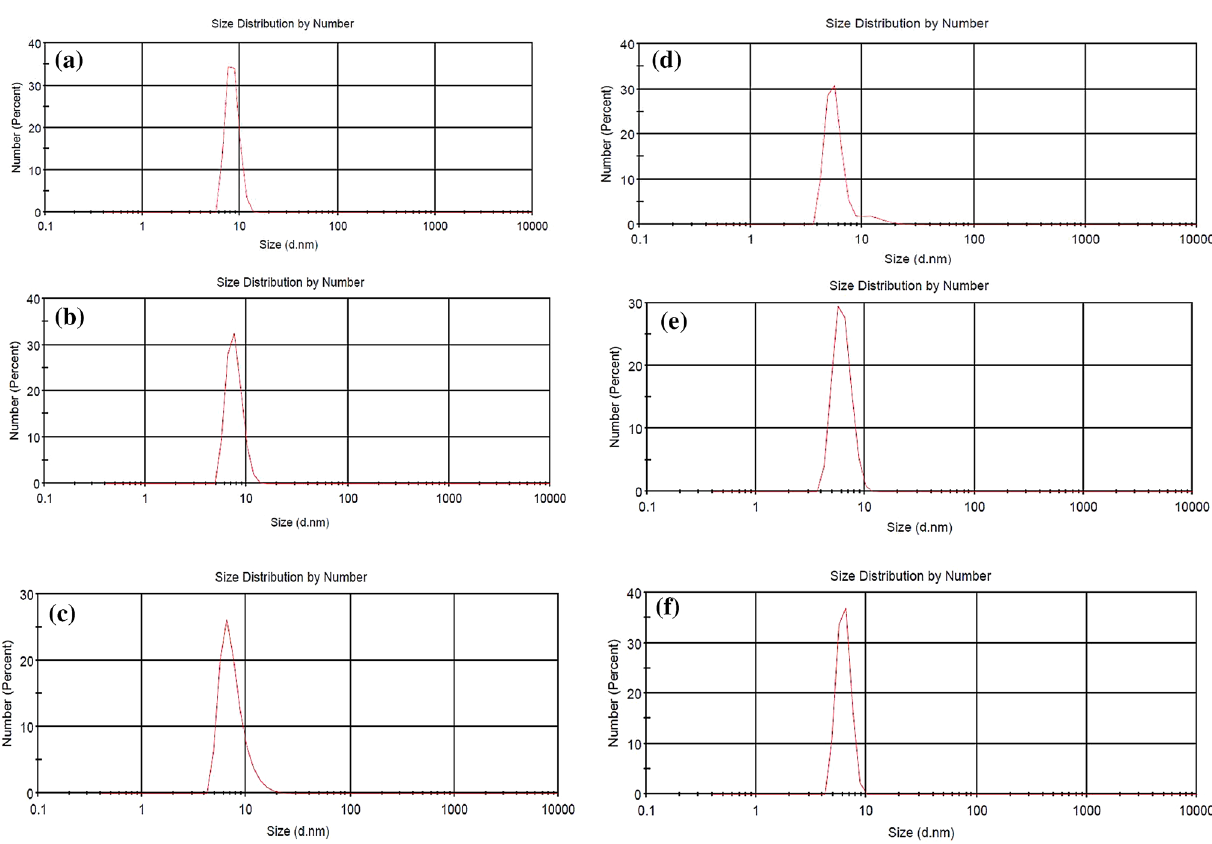
Fig. 2 a Particle size distribution of Tergitol 15-S-7 + TX-405 in DW. b Particle size distribution of Tergitol 15-S-7 + TX-405 in 2000 ppm brine. c Particle size distribution of Tergitol 15-S-7 in DW. d Particle in 2000 ppm brine Table 8 Particle size analysis of Tg7, TX and